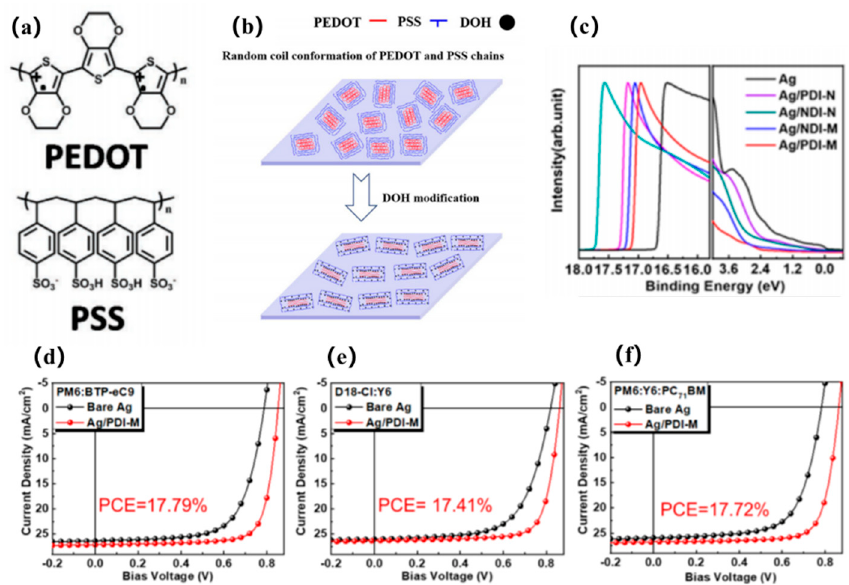
Figure 4. ( a ) Molecular structures of PEDOT and PSS. ( b ) The conformational transformation of PEDOT and PSS chains. ( c ) UPS of various ETLs ( d – f ), J – V curves of different OSCs with and w/o PDI-M as ETL. Adapted with permission from Ref. [88]. Copyright 2021 American Chemical Society.